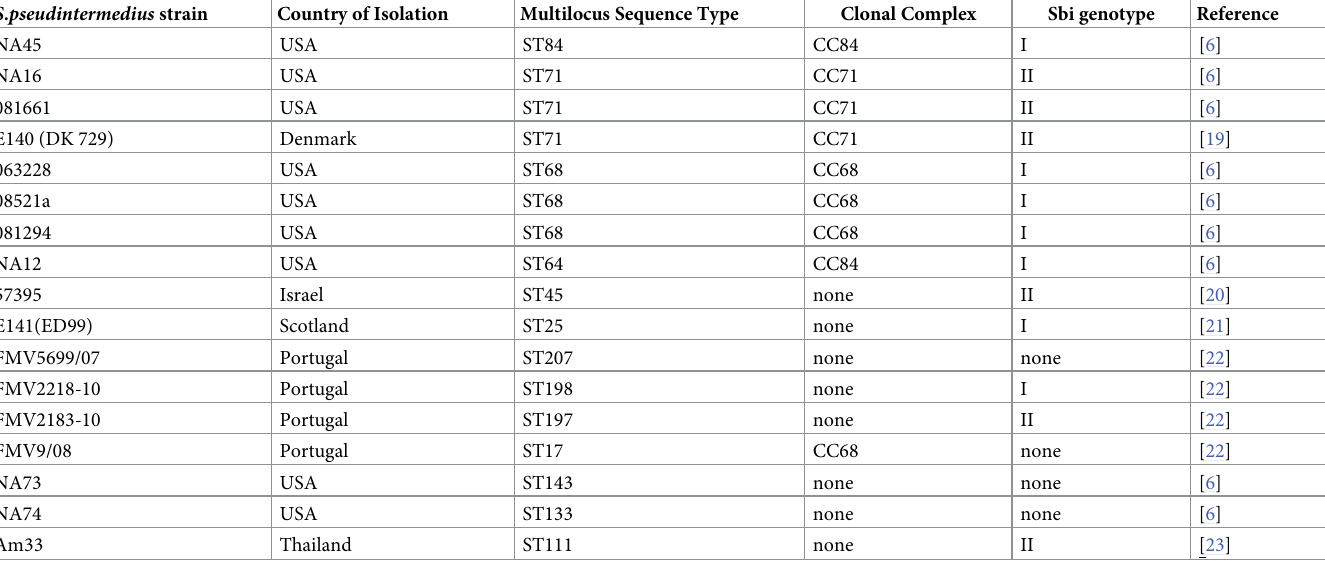
Table 1. Origins and sequence type of S . pseudintermedius